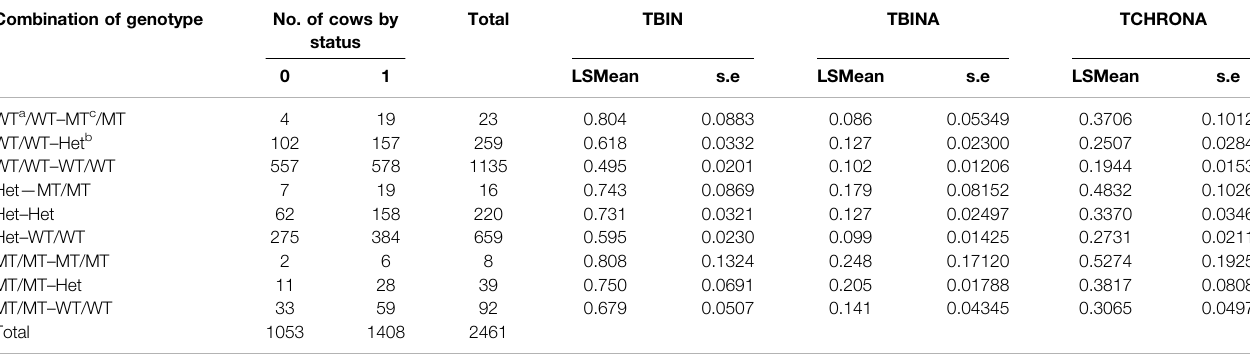
TABLE 4 | Combination of FRET results for BTA11 (rs208894039) x BTA19 (rs109521151) genotypes for traits TBIN, TBINA, and TCHRONA. The BTA11 variant is listed fi rst, followed by the BTA19 genotype. Signi fi cant contrasts between genotypes are given in Supplementary Table S4 . Combination of